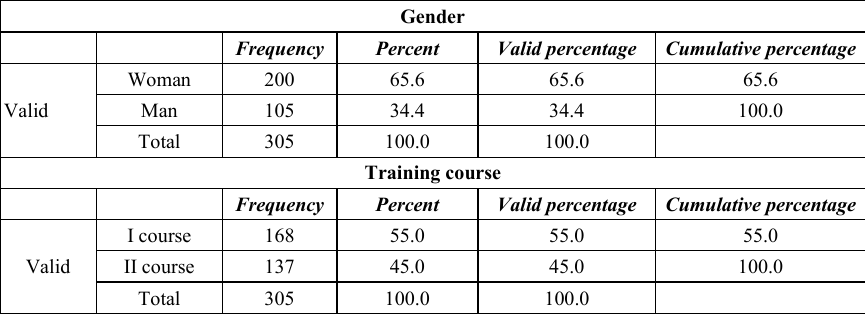
Table 1. Information on the student